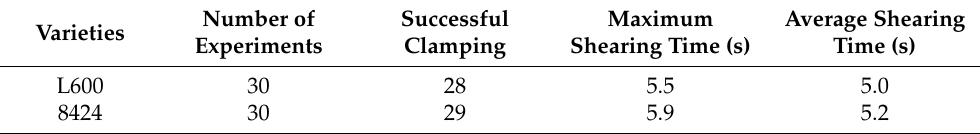
Table 3. End-effector experiment